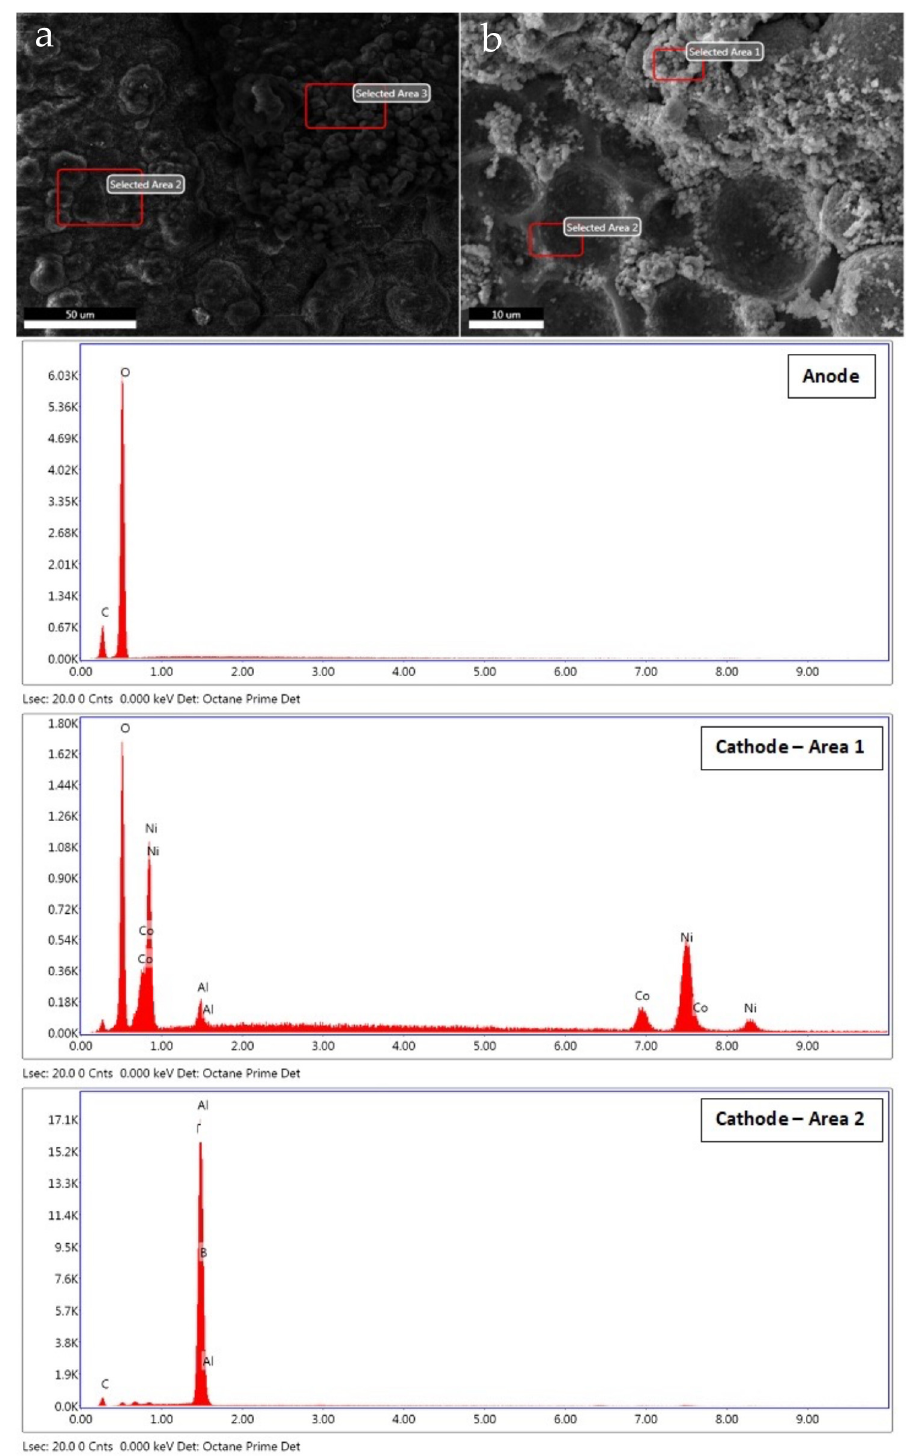
Figure 12. SEM-EDS analysis of the cell electrodes after the cone calorimeter test A4 ( a ) anode (Area 2) (1500×); ( b ) cathode (Area 1 and Area 2) (5000×).